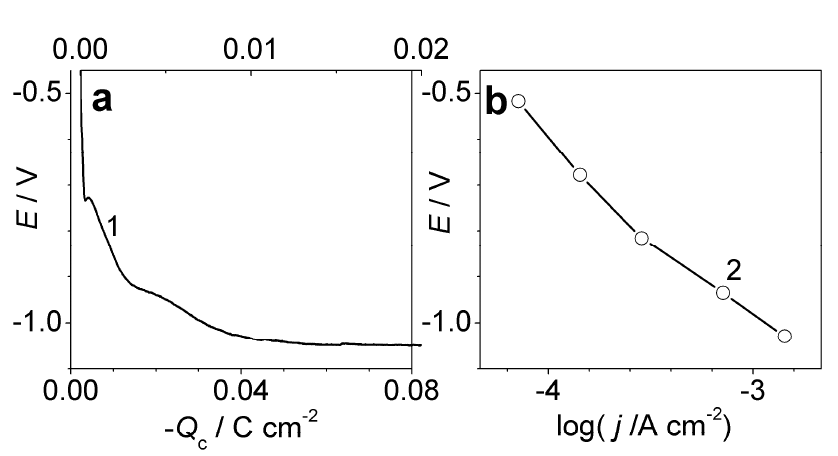
Fig. 6 (a) Potential decay curve following a –0.07 mA cm − 2 current step from the cor- rosion potential: for Fe